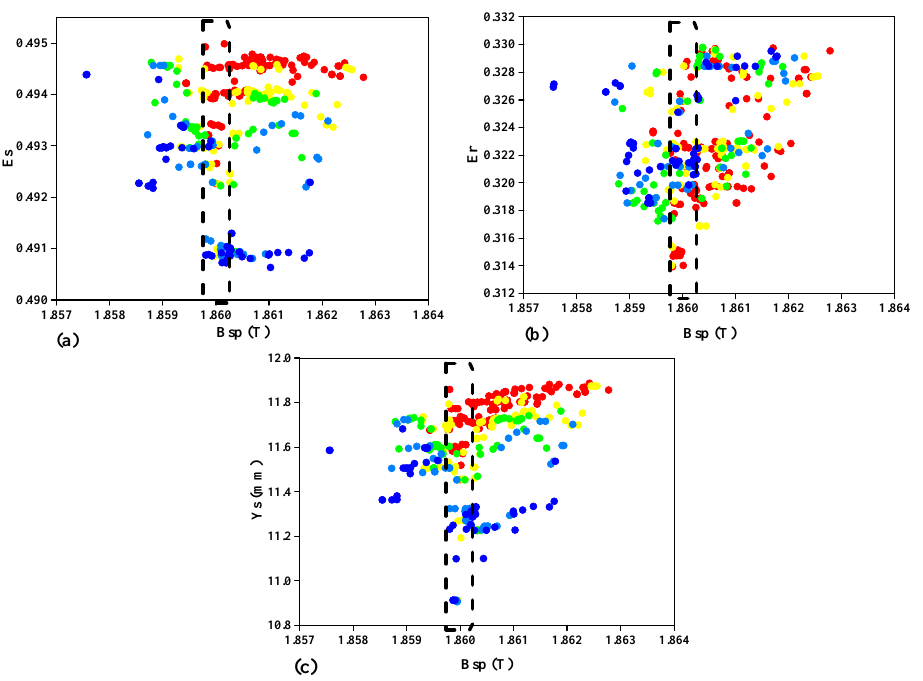
Figure 12. Tradeoff plot of input variables with B sp ( a ) E s with B sp ( b ) E r with B sp ( c ) Y s with B sp . The input solutions highlighted in the dashed-line box dominate other solutions in the white areas since they are generated around 1.86 T . The best to worst solutions go from red to